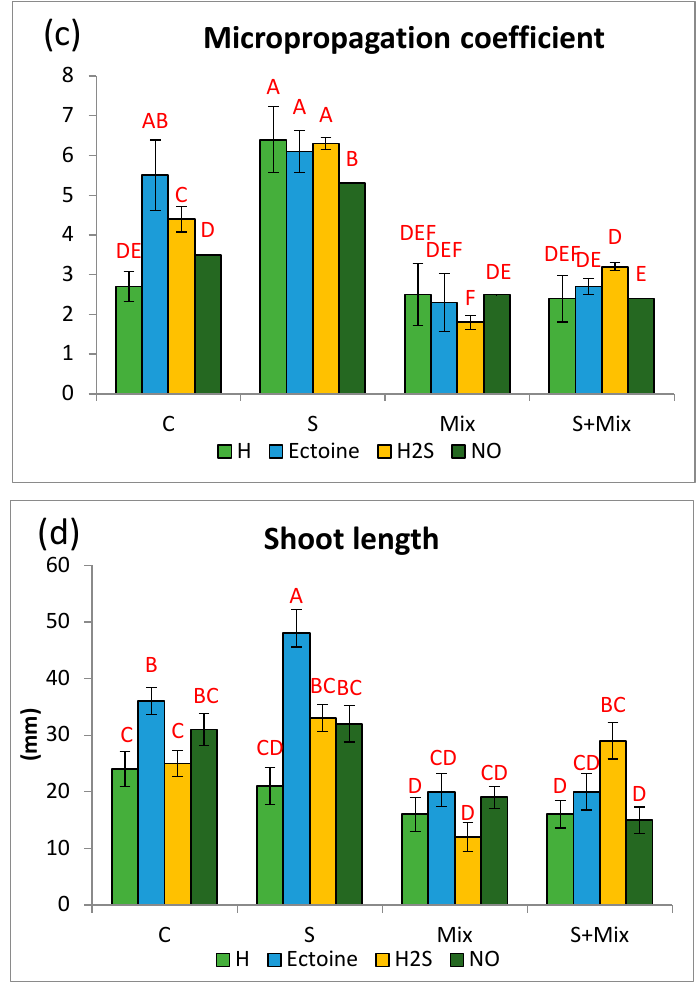
Figure 1. Growth parameters of Lobularia maritima shoots subjected to priming prior to stress exposure: ( a ) shoot fresh weight; ( b ) shoot dry weight; ( c ) micropropagation coefficient; ( d ) shoot length. Upper case letters indicate statistical significance of means acc. two-way ANOVA. Applied primers: H—water (hydropriming), Ect—ectoine, H2S—hydrogen sulfide donor GYY4137, NO—nitric oxide donor sodium nitroprusside. Treatments: C—control; S—low salinity (20 mM NaCl); Mix—metals: